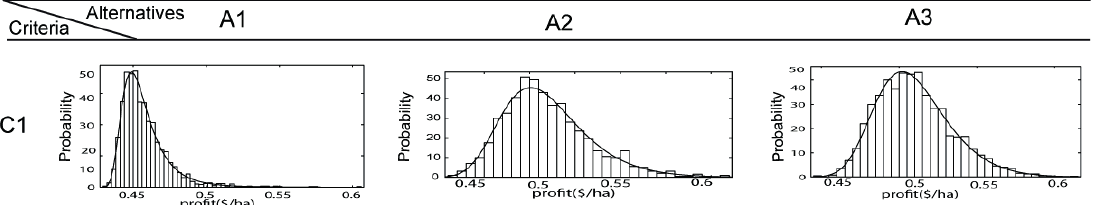
Fig. 3 The decision matrix values – histogram and fitted probability distribution